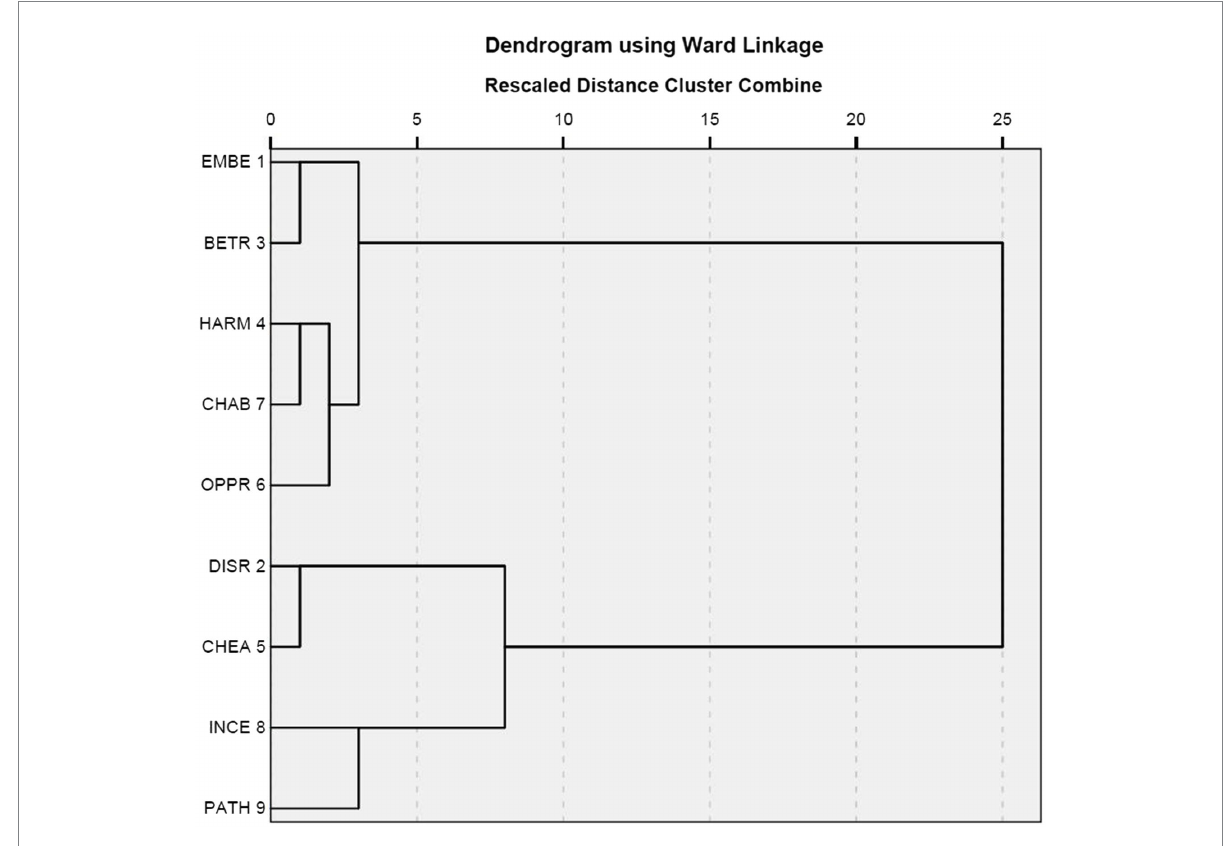
FIGURE 5 Cluster analysis on emotional